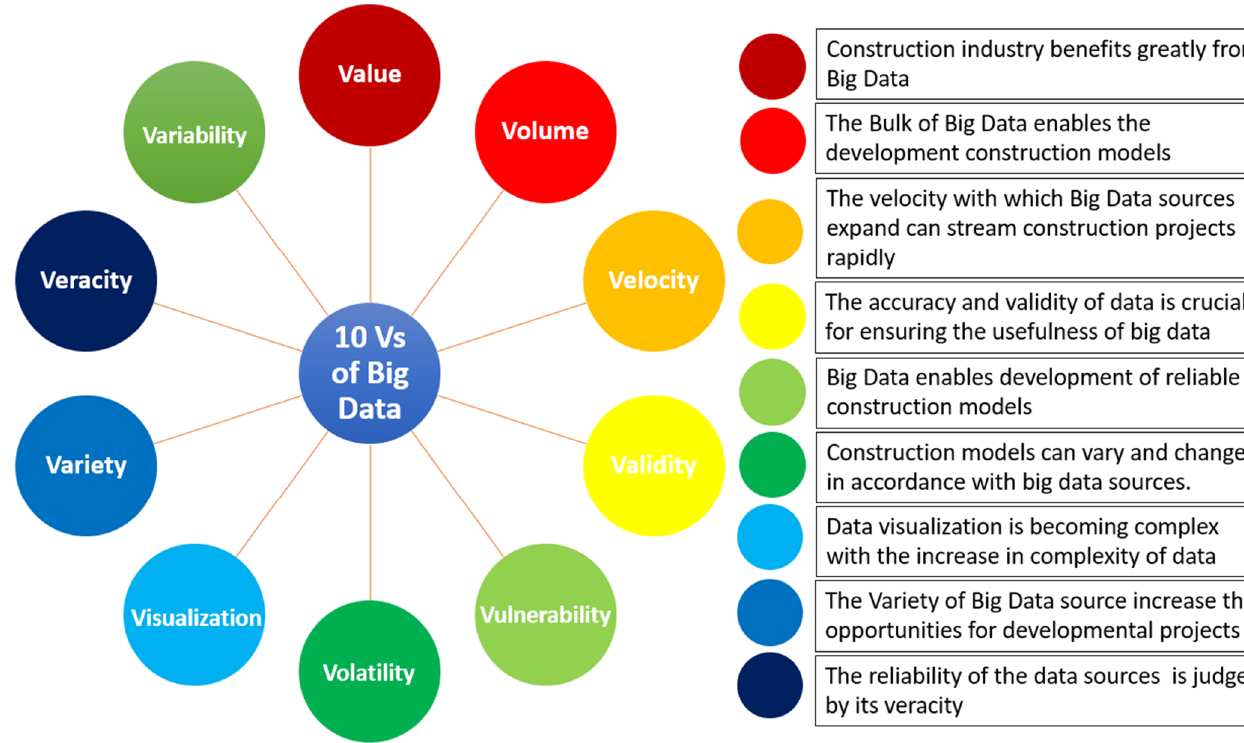
Figure 9. The 10 vs. of big data.